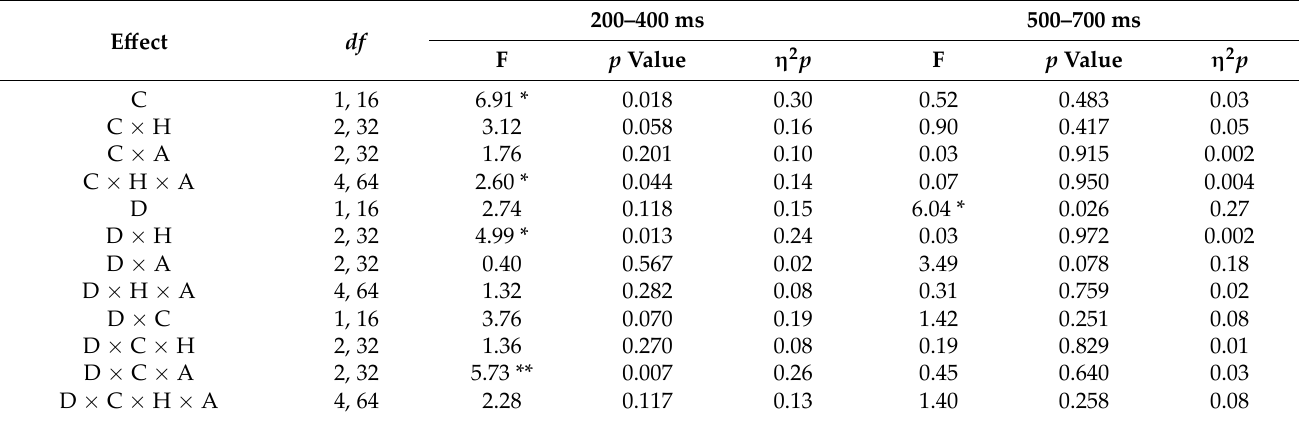
Table 2. ERP results of repeated‑measures